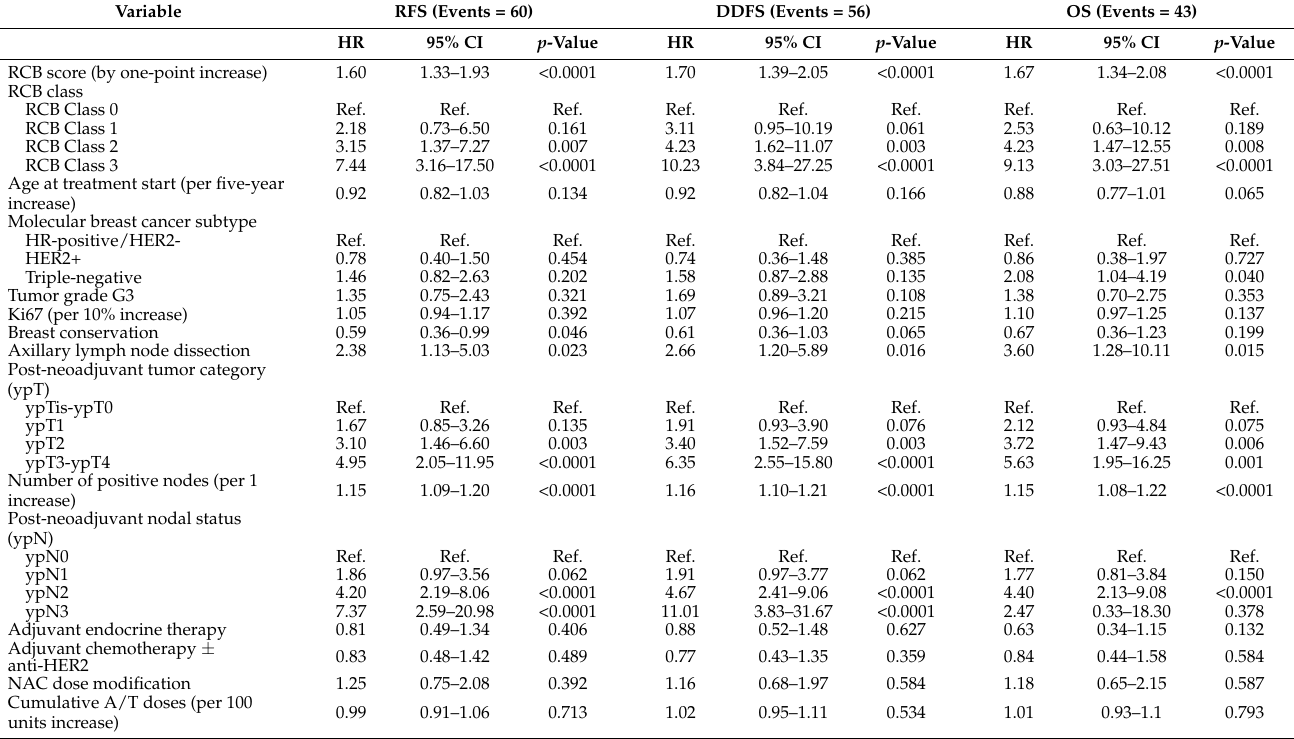
Table 2. Univariable predictors of five-year RFS, DDFS, and OS in the study cohort ( n =